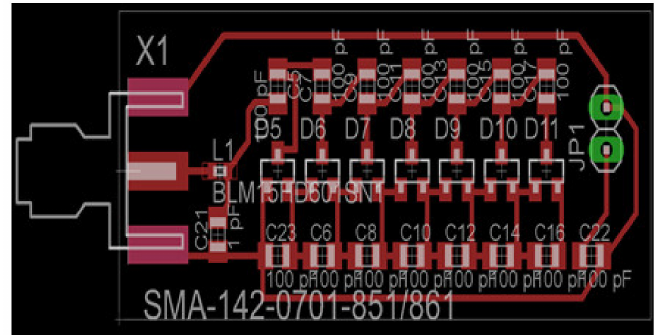
Figure 16. Schematic diagram of Cockcroft–Walton voltage multiplier rectifier designed with EA- GLE software.